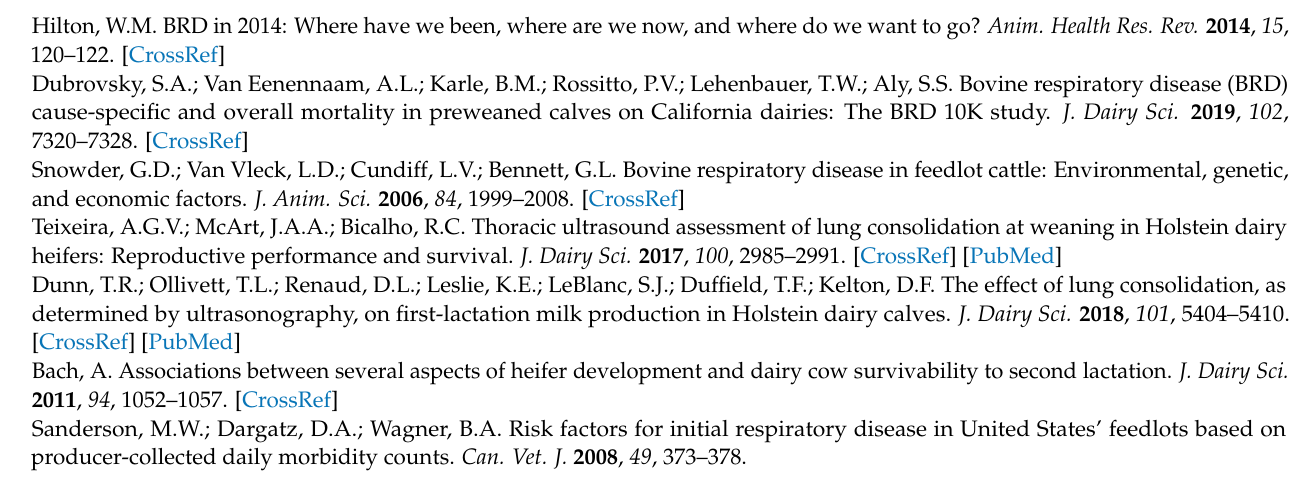
Germany, Table S6: Annual multidrug-resistance (MDR) rates of P. multocida and M. haemolytica over of multidrug-resistant (MDR) Pasteurella multocida and Mannheimia haemolytica isolates and certain animal and farm characteristics over the five-year period 2015–2020 in Bavaria, Germany, Table S8: Overview of Pasteurella multocida and Mannheimia haemolytica isolates included in the study with corresponding resistance pattern, animal characteristics and farm